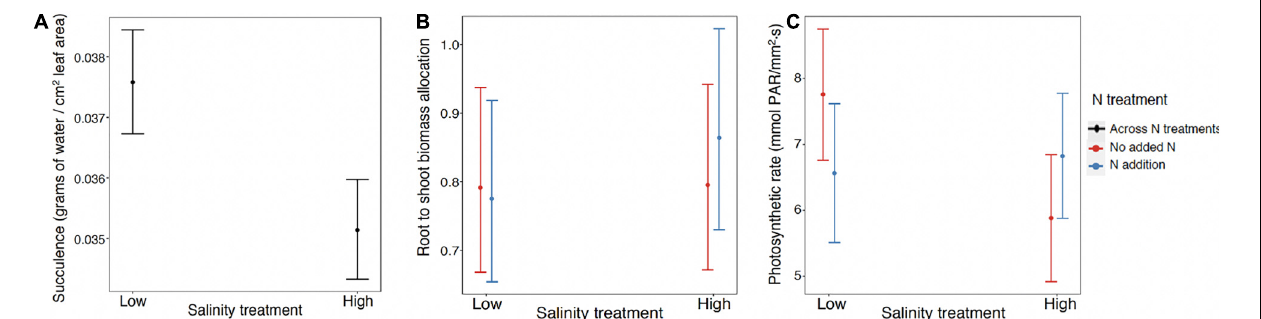
FIGURE 3 | (A) Succulence response to salt across populations with no N effect, including the random effects of maternal families within populations and populations ( N = 818). Interaction effect for (B) root to shoot biomass allocation and (C) photosynthetic rate where response to N depends on salt treatment across all mangrove propagules. The best model for root to shoot biomass allocation ( N = 899) also includes the fixed effect of salt and random effects of population, maternal family within population and block. The best model for photosynthetic rate ( N = 118) does not include any of the random